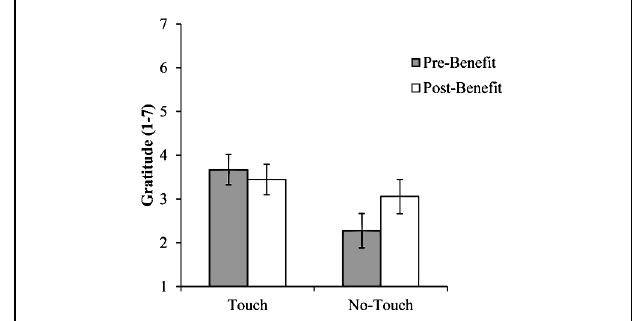
FIGURE 1 | Pre- and post-benefit gratitude as a function of touch condition, Study 1 ( N = 36). Error bars represent SEM.